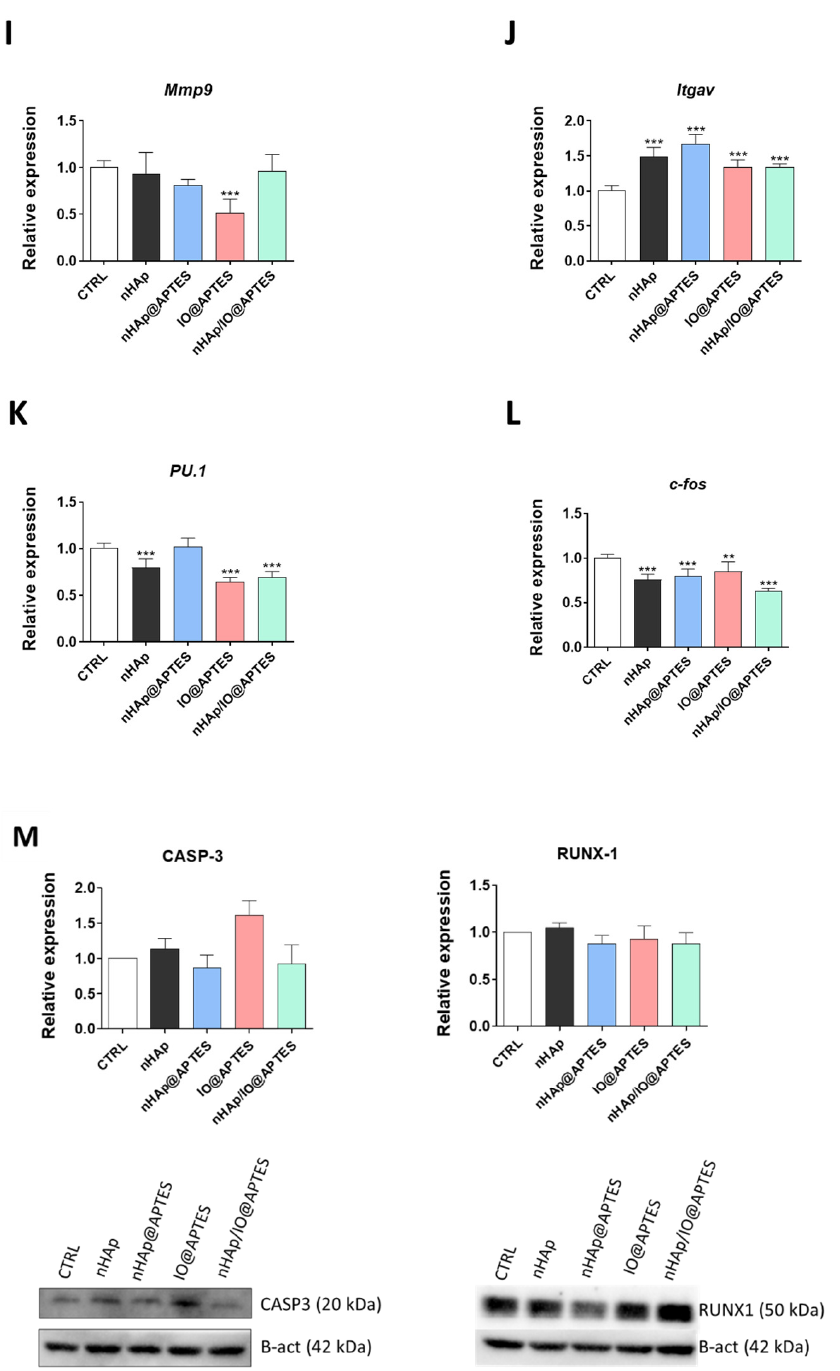
Figure 7. The influence of biomaterials on osteoblasts and osteoclasts. The impact of the biomaterials on the expression of genes associated with osteogenesis Runx2 ( A ), Alp ( B ), Col1a-1 ( C ), Opn ( D ), Bglap2 ( E ) and Dmp1 ( F ) after 20 h of incubation of MC3T3-E1 cell line and the results of Western blot for RUNX1, RUNX2 I, RUNX 2 II ( G ) and COL1A1, OPN I and OPN II ( H ). The impact of the biomaterials on the expression of genes associated with osteoclast activities Mmp9 ( I ), Itgav ( J ), PU.1 ( K ) and c-fos ( L ) after 20 h of incubation of 4B12 cell line. The amount of CASP-3 and RUNX-1 in osteoclasts ( M ). The graphs represent mean values ± standard deviation. Significant differences are indicated as follows: (* p < 0.05, ** p < 0.01 and *** p < 0.001).